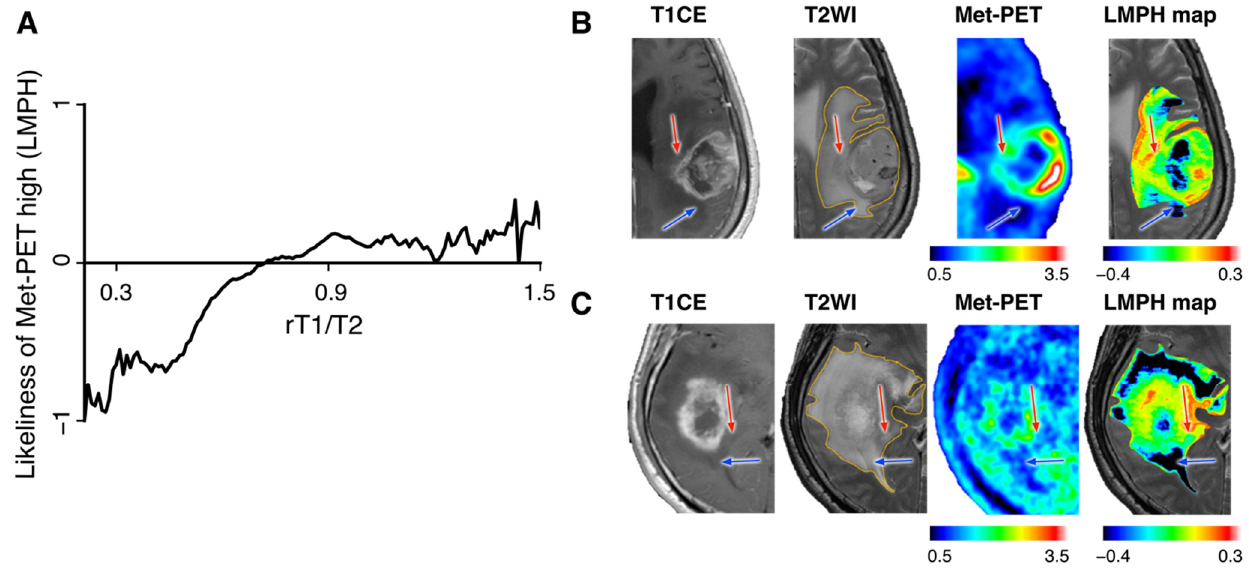
Figure 4. LMPH values are plotted as a function of rT1/T2 using all available 34 cases ( A ). Representative cases demonstrating the usefulness of the LMPH map are shown ( B , C ). Red and blue arrows indicate the lesions whose Met-PET high or low was accurately predicted by LMPH within T2/FLAIR high-intensity lesions, respectively.